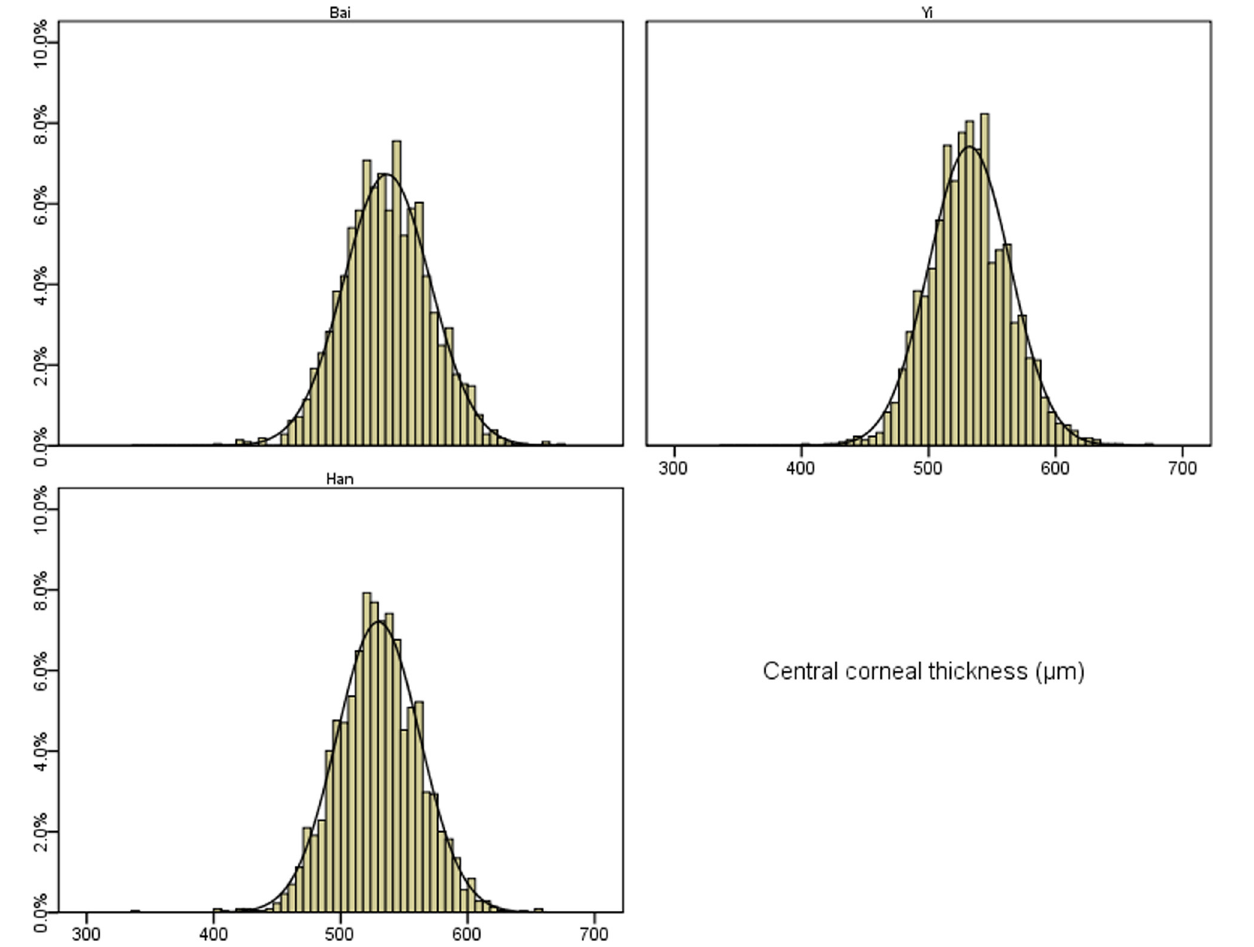
Fig 1. Distribution of central corneal thickness among the three ethnic groups.